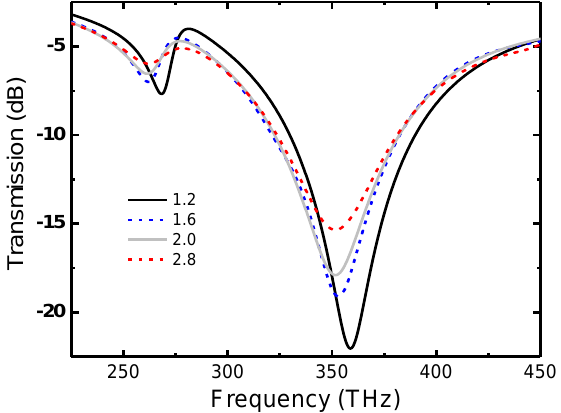
Figure 7. Dark and bright mode resonances for collision frequency varying from 1.2 to 2.8 × 10 14 s −1 and α = 30